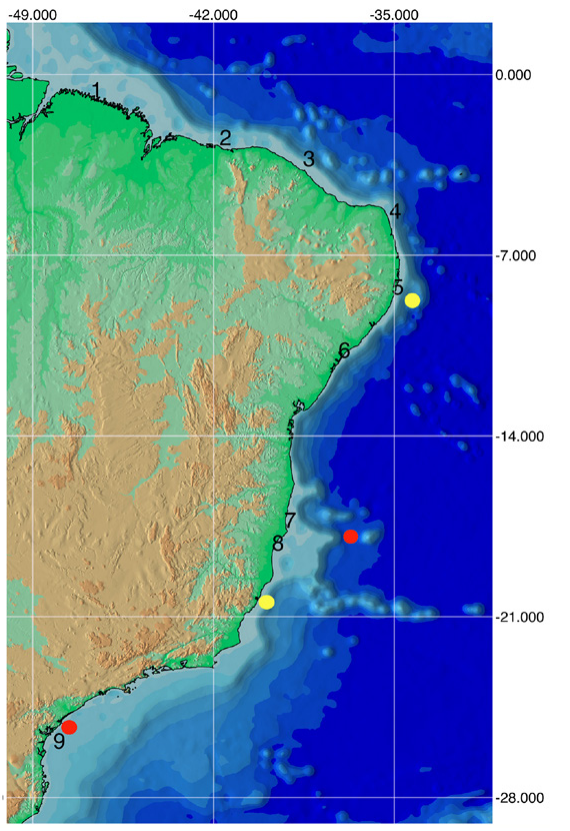
Fig. 1. – Map of locations sampled on the coast of Brazil for popula- tion genetic characterization of Atlantic goliath grouper ( Epinephe- lus itajara ) offshore Brazil. 1, Bragança; 2, Parnaíba; 3, Fortaleza; 4, Natal; 5, Tamandaré; 6, Vaza Barris; 7, Caravelas; 8, Conceição da Barra; 9, Babitonga. Red circle, site of aggregations ≥30 sight- ings; Yellow circle, Site of aggregations 11 to 29 sightings of E. itajara (Giglio et al. 2014).